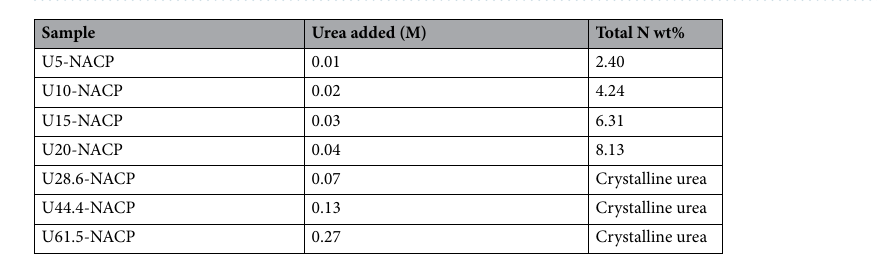
Table 1. Synthetic conditions for the materials prepared during the optimization of the amount of urea adsorbed in the NPs. In all cases, solution A contained Na 3 (Citrate) (0.20 M) and Ca(NO 3 ) 2 (0.20 M); solution B contained K 2 HPO 4 (0.12 M), Na 2 CO 3 (0.10 M) and KNO 3 (0.20 M). The concentration of urea is calculated as amount of urea added per total volume of the reaction. The total nitrogen content (wt%) from elemental analysis is provided for fully amorphous